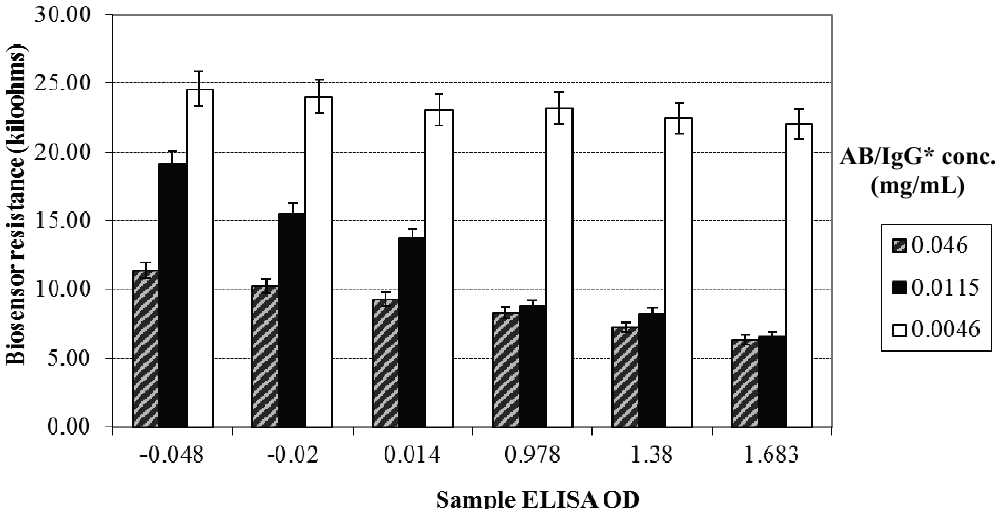
Figure 2. Mean biosensor resistance values of six serum samples at different AB/IgG* concentrations (mg/mL). ELISA OD <0.1 = JD negative, ≥ 0.1 = JD